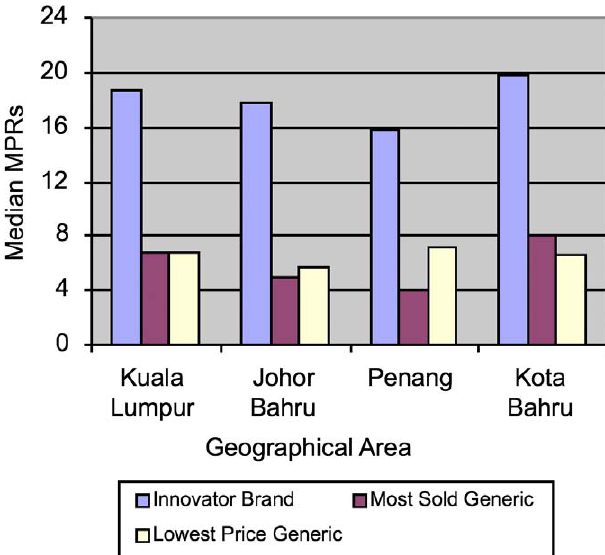
Figure 1. Regional Variation in Median MPRs in Private Retail Sector Pharmacies